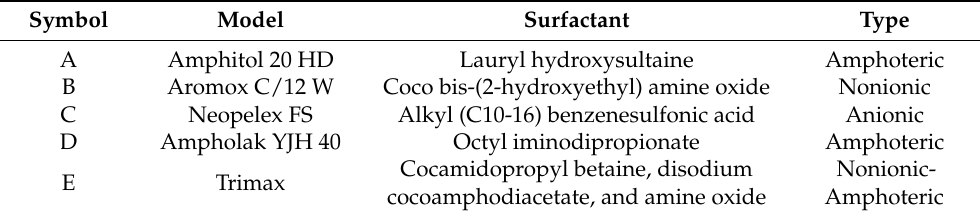
Table 1. List of surfactants used in the CO 2 foamed acid experiment.